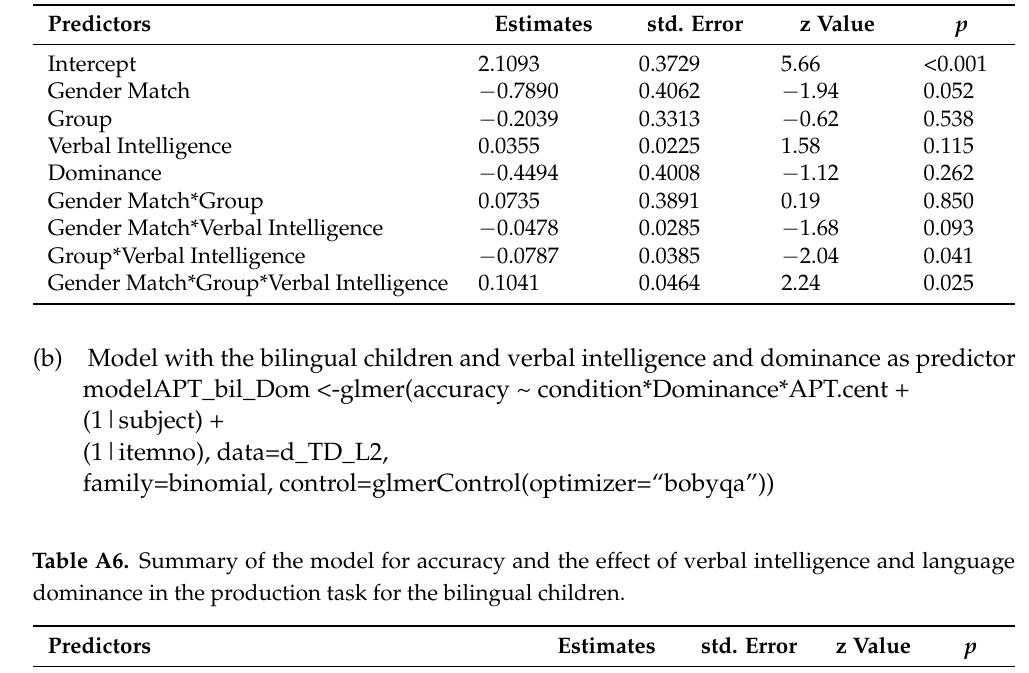
Table A5. Summary of the model for accuracy and the effect of verbal intelligence and language dominance in the production task for the whole dataset.